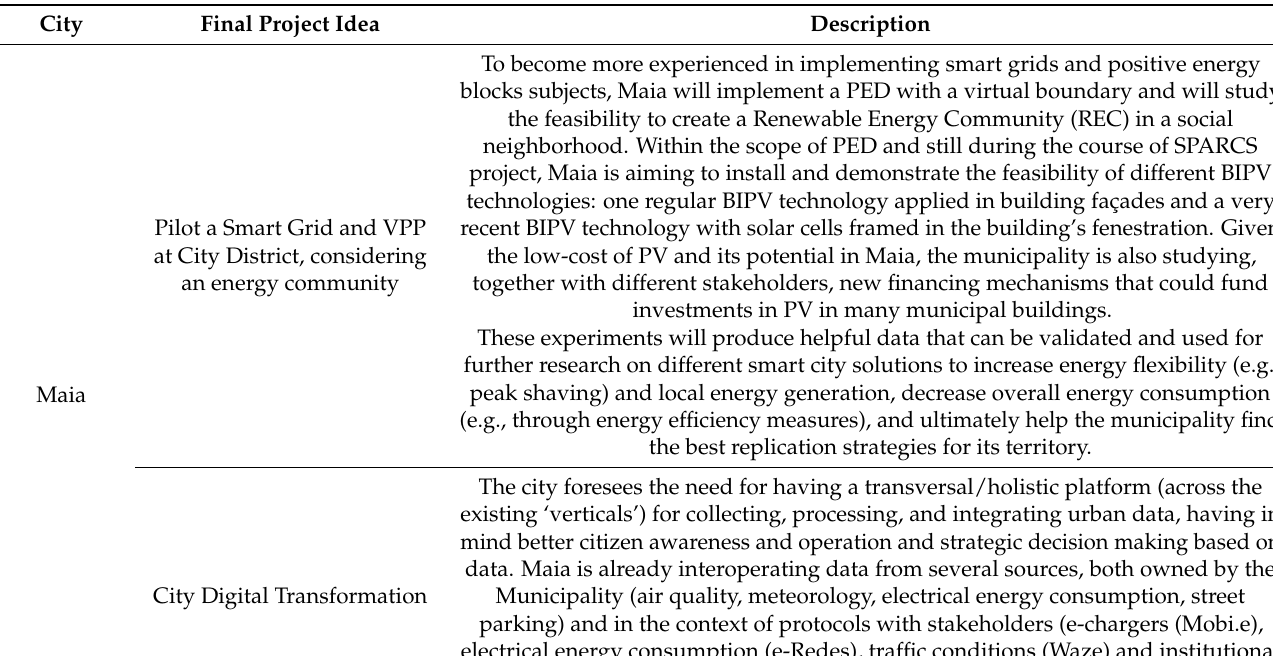
Table 5. Final list of project ideas to be further developed (more details in the implementation plans